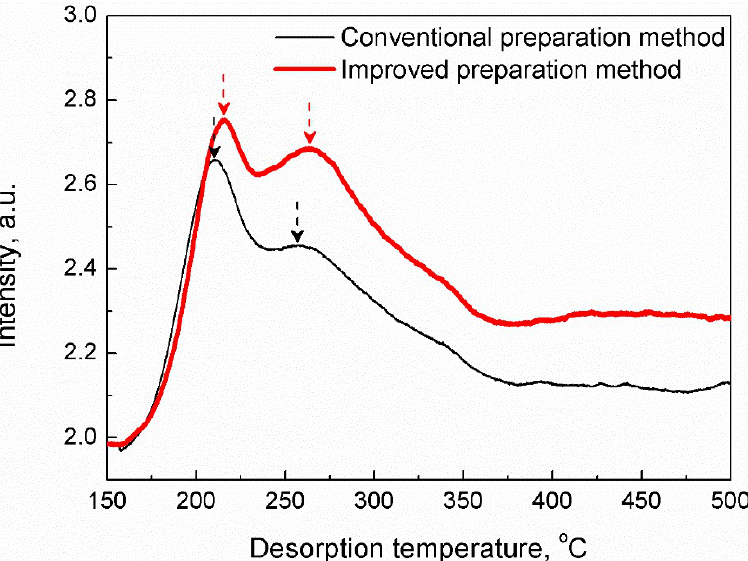
Figure 3. NH 3 -TPD profiles of as-prepared Co/fumed SiO 2 catalysts using different approaches.